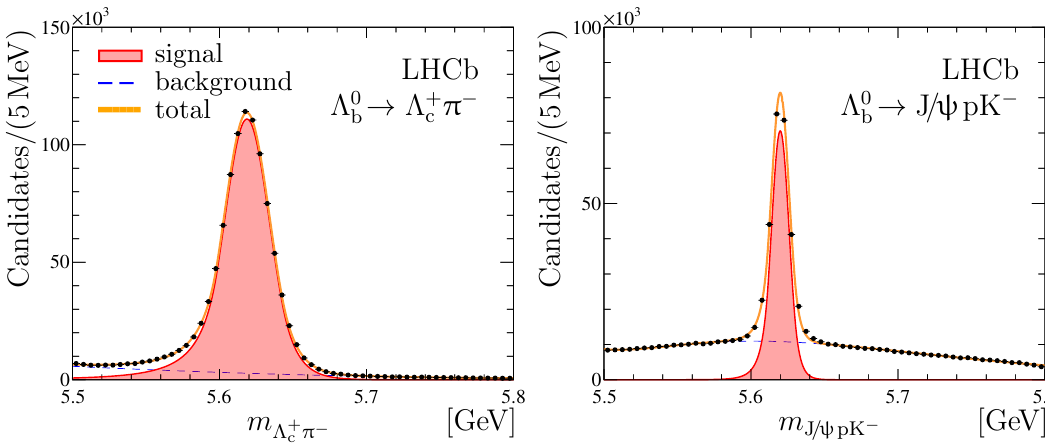
Figure 1 . Mass distributions for selected (left) (cid:3) 0 after BDT selection. A (cid:12)t, composed of a sum of a double-sided Crystal Ball function [46] and a smooth background component, is